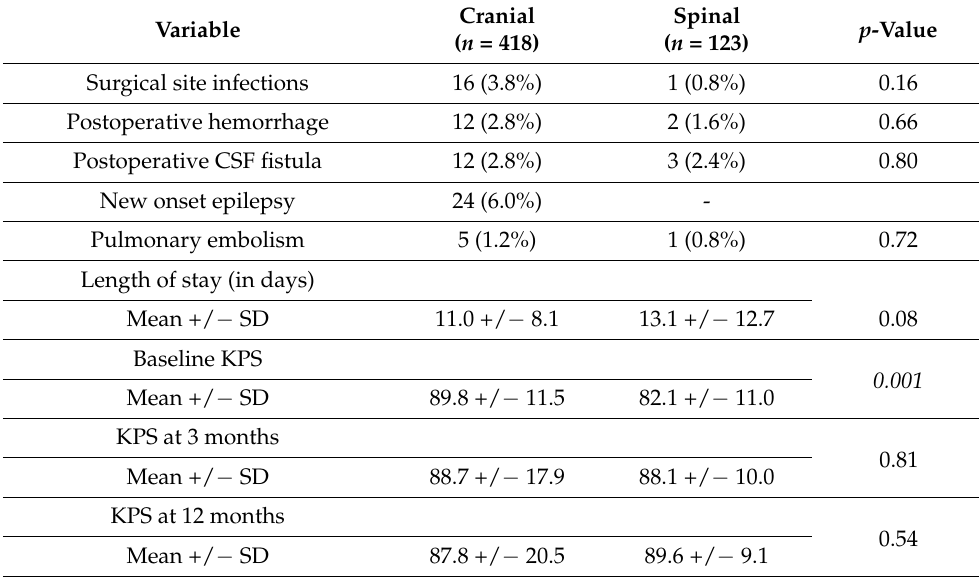
Table 5. Complications requiring revision surgery, length of stay and postoeprative course of physical status among cranial and spinal WHO grade 1 and 2 meningiomas ( n = 541). Statistical analysis was performed using independent t -test and Pearson’s chi-squared test